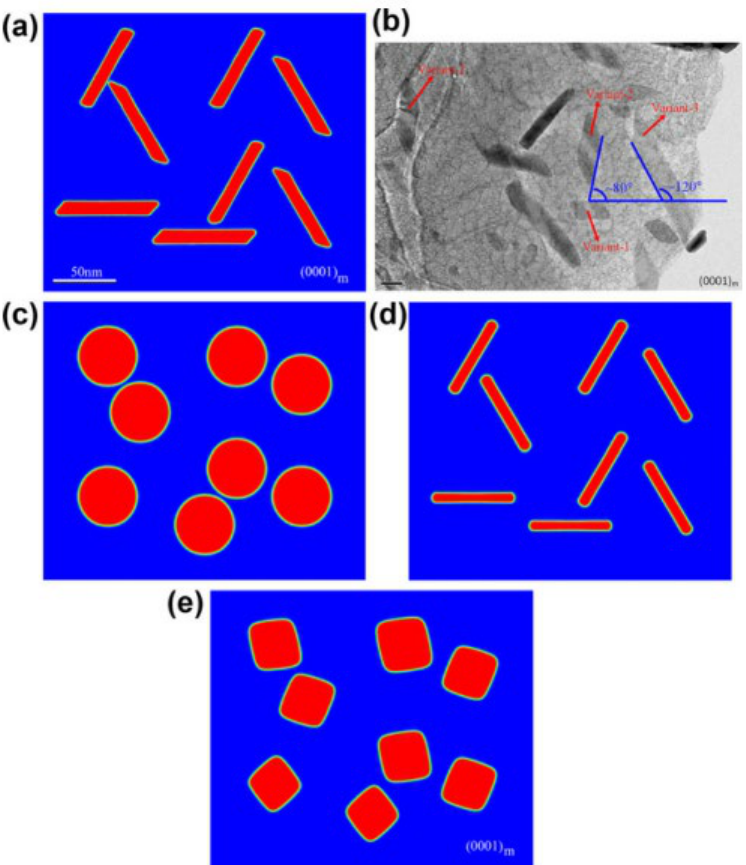
Figure 18. Simulation and TEM observation of multi-variant precipitation: ( a ) considering the interface anisotropy and the elastic strain energy, ( b ) TEM bright-field image of the precipitates for AZ91 aged at 441K for 16 h, ( c ) without considering the interface anisotropy and the elastic strain energy, ( d ) considering only the interface anisotropy, and ( e ) considering only the elastic strain energy